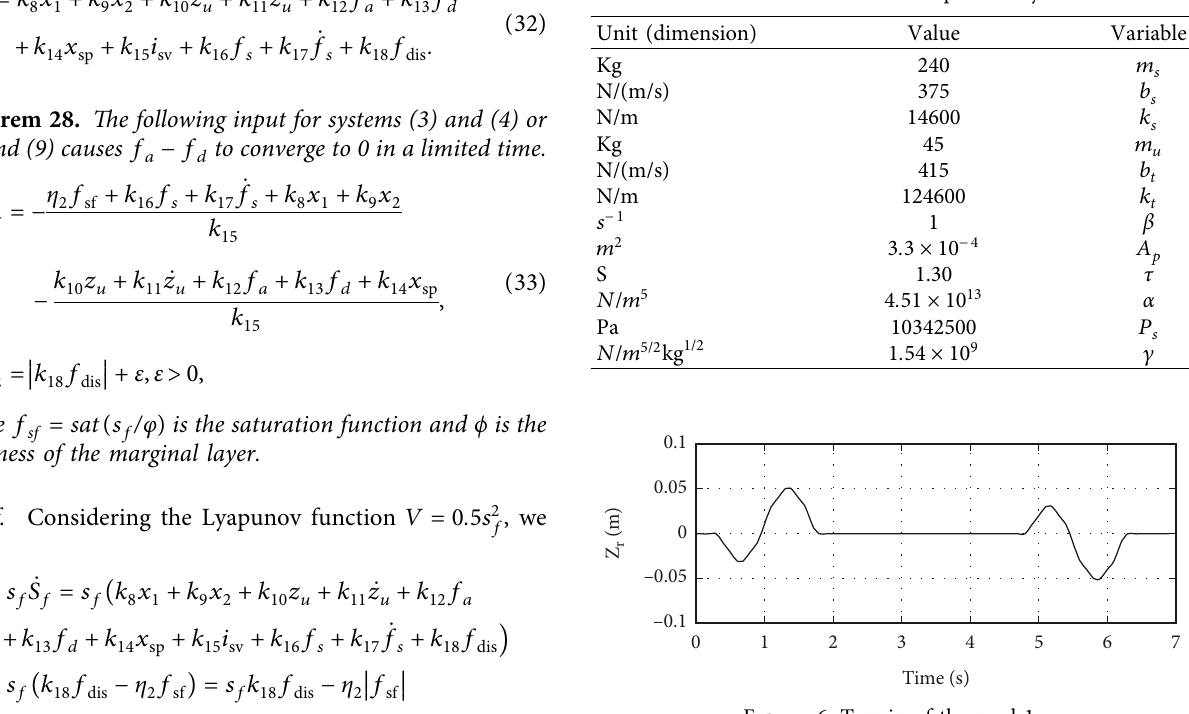
Table 1: Parameters of suspension system.